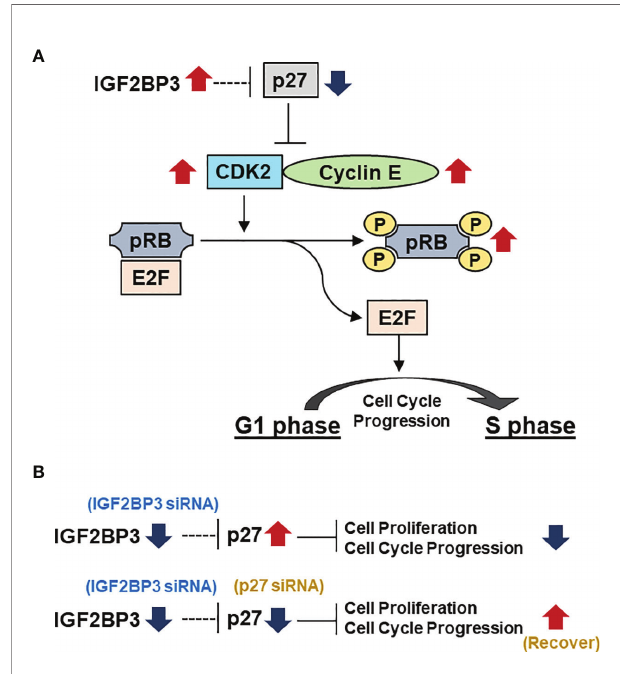
FIGURE 6 | IGF2BP3 represses p27, thereby affecting the downstream pathway and fi nally causing G1 arrest. (A) IGF2BP3 activates the CDK2/ Cyclin E complex by repressing p27, which leads to the phosphorylation of RB and the release of the transcription factor E2F from RB, leading to the progression from G1 to S phase in the cell cycle. (B) Transfection with IGF2BP3 siRNA alone results in inhibition of cell proliferation with G1 phase arrest by increasing the expression of p27. Simultaneous transfection with IGF2BP3 and p27 siRNA prevents p27 upregulation by IGF2BP3 siRNA, leading to alleviation of G1 phase arrest and restoration of cell